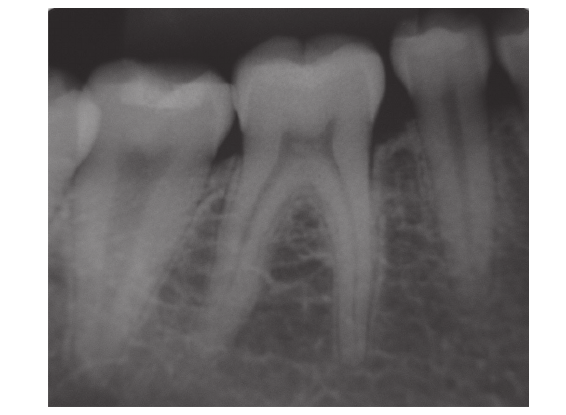
Figura 2 − Radiografia periapical mostrando pequena perda de crista óssea na região